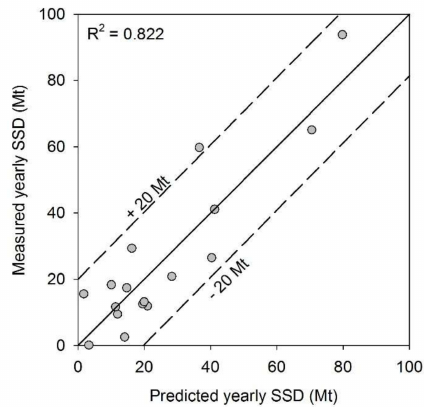
Figure 9. Comparison of predicted and measured yearly suspended sediment